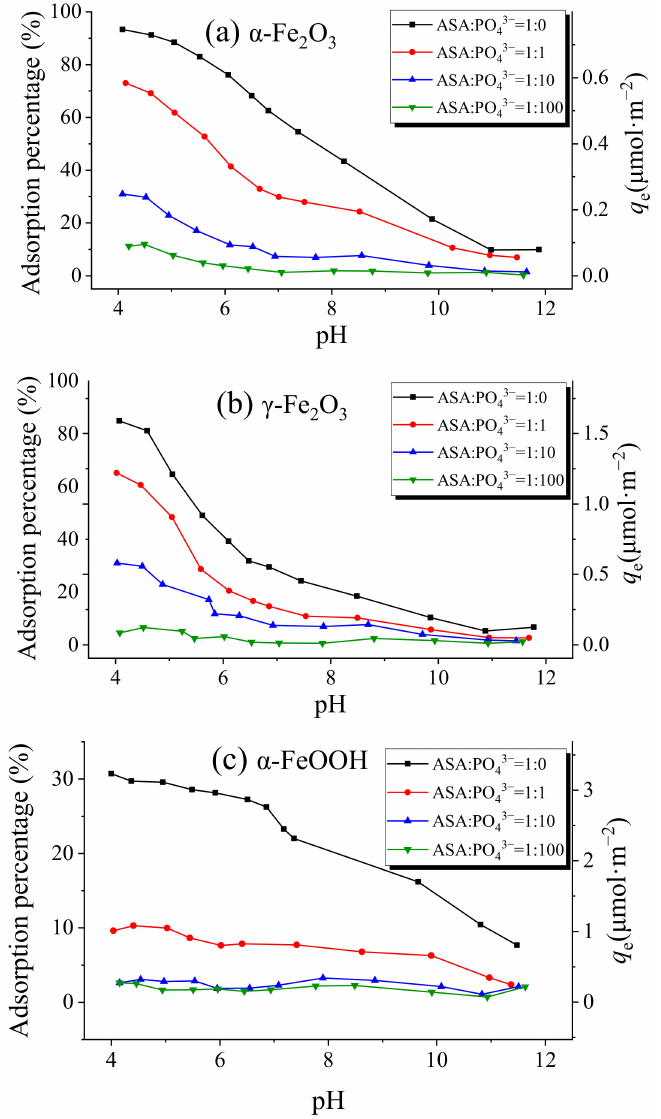
Figure 4. Effect of phosphate on ASA adsorption. Solid points are experimental data; polylines are for the visual guide. ASA = 20 µ M, iron oxdies = 0.2 g · L − 1 , and NaCl = 10 mM. ( a ) α -Fe 2 O 3 , ( b ) γ -Fe 2 O 3 , ( c ) α